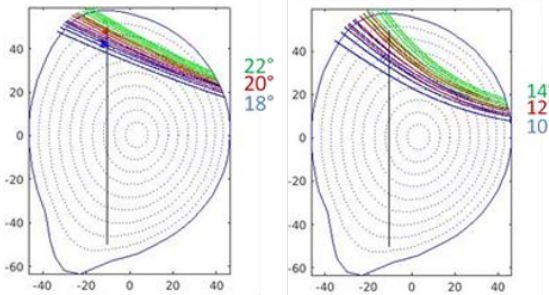
Figure 3: Poloidal projection of the ray trajectories for a line- averaged density of 2×10 19 m -3 (left) and 9×10 19 m -3 (right). The vertical black line shows the EC resonance layer. The corresponding poloidal injection angles are indicated in the